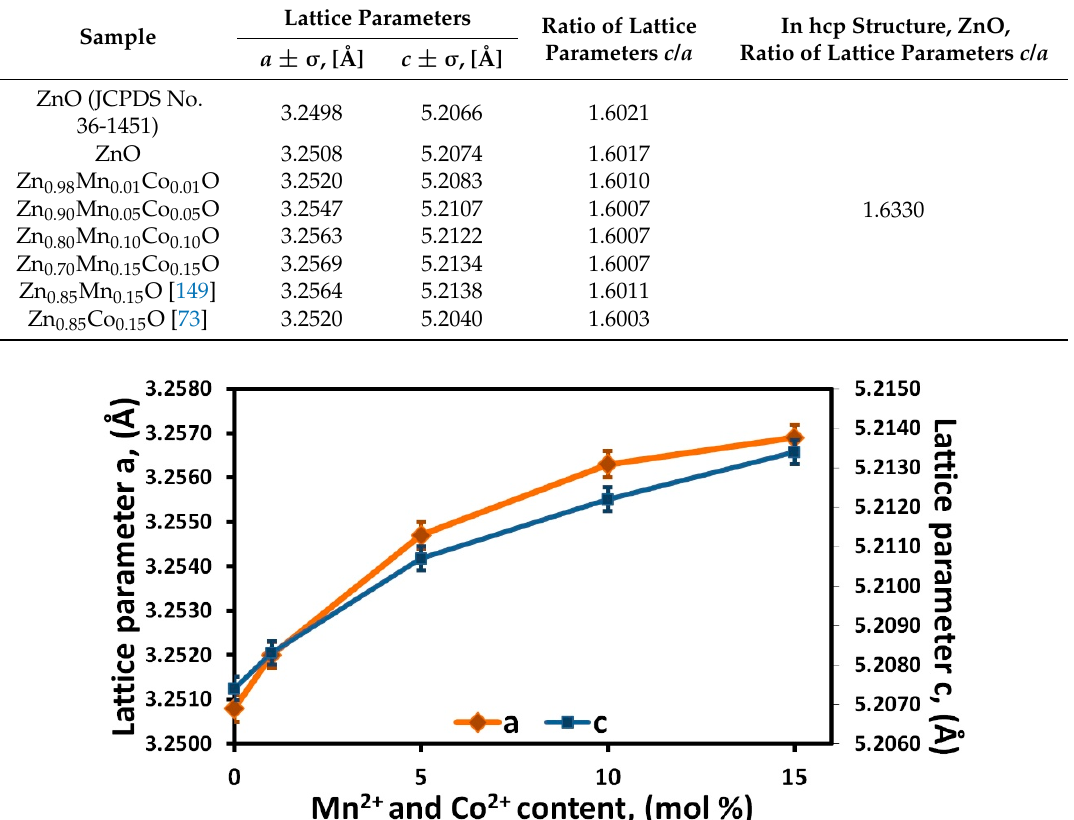
(1 − x − y) Mn x Co y O NP